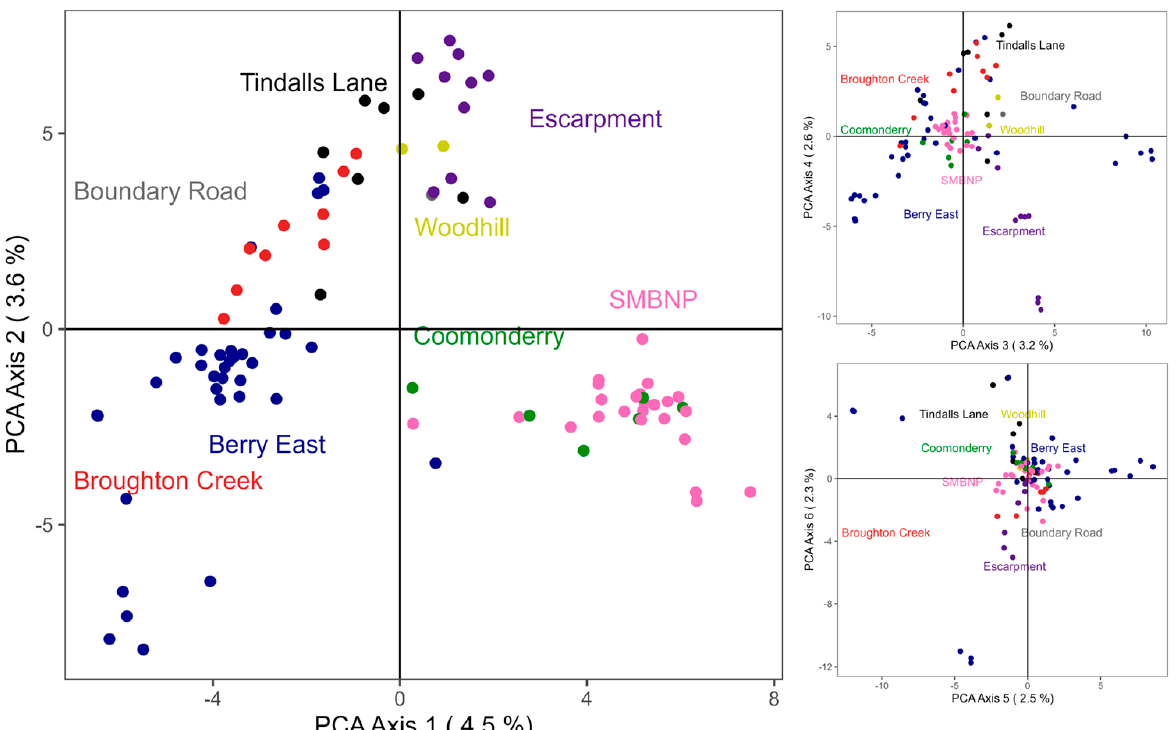
Figure 2. Principal coordinates analysis (PCoA) based on the genetic distances of 94 sugar glider individuals from 8 sampling locations using 5999 SNPs. Dots represent each individual. Colours represent their respective sampling location. ( Left ): representation of the first and second PCoA axes, followed by the third and fourth ( top right ) and fifth and sixth ( bottom right ). The AMOVA found that most of the genetic variation (90.03%) was explained by within-individual sugar glider variations, while only 5.12% of the genetic variation could be attributed to individuals within sampling locations (Table 2). The remaining 4.86% of genetic variation was explained by sampling locations (Table 2). Table 2. Percentages of molecular variance within sugar glider individuals, between individuals within sampling locations, and between sampling